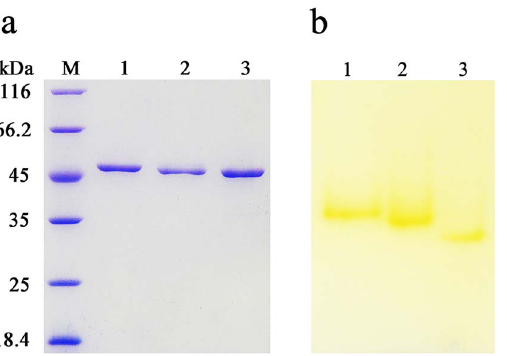
Figure 4. Purified Lac15-His 6 (lane 1), Lac15 (lane 2), and Lac15D (lane 3) assayed by (a) SDS-PAGE and (b) native-PAGE. Activity staining of laccases was performed in 50 mM Na 2 HPO 4 –KH 2 PO 4 buffer (pH 7.5) after PAGE using syringaldazine as the substrate.